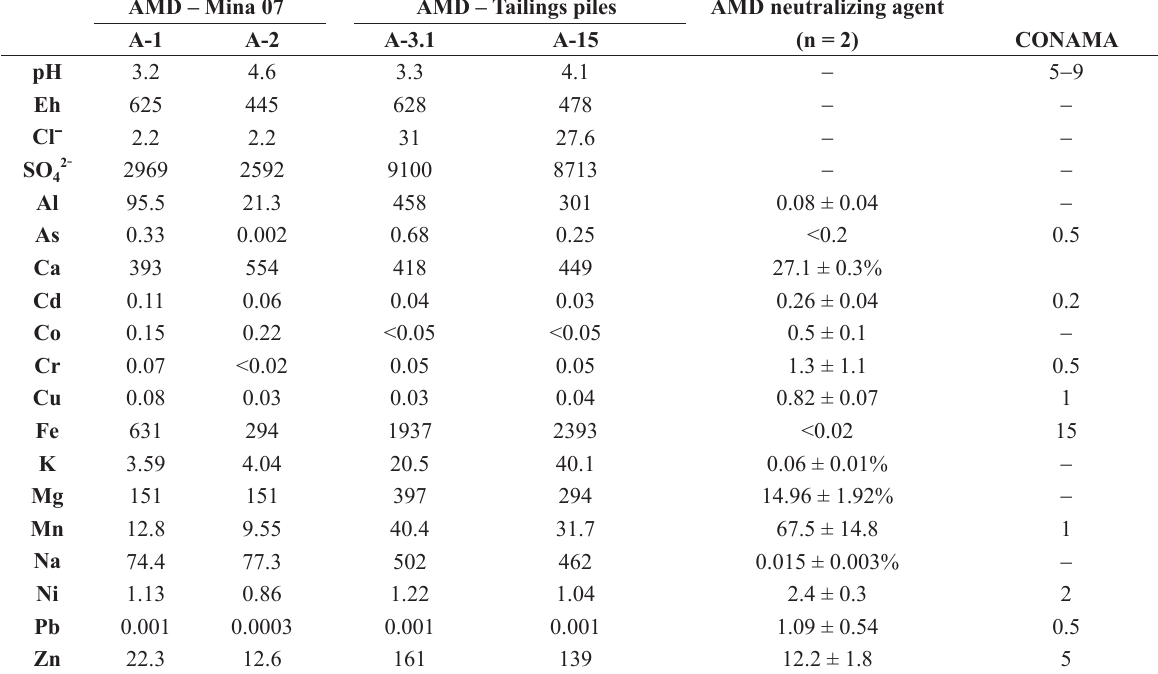
Values of pH, Eh (mV) and chemical concentrations in acid drainage (in mg L −1 ) and neutralizing AMD agent (CaO for commercial use made by calcareous sedimentary rock upon calcination; in mg kg −1 , except those indicated with %). Values shown with the “less than” symbol (“<”) are detection limits, and CONAMA